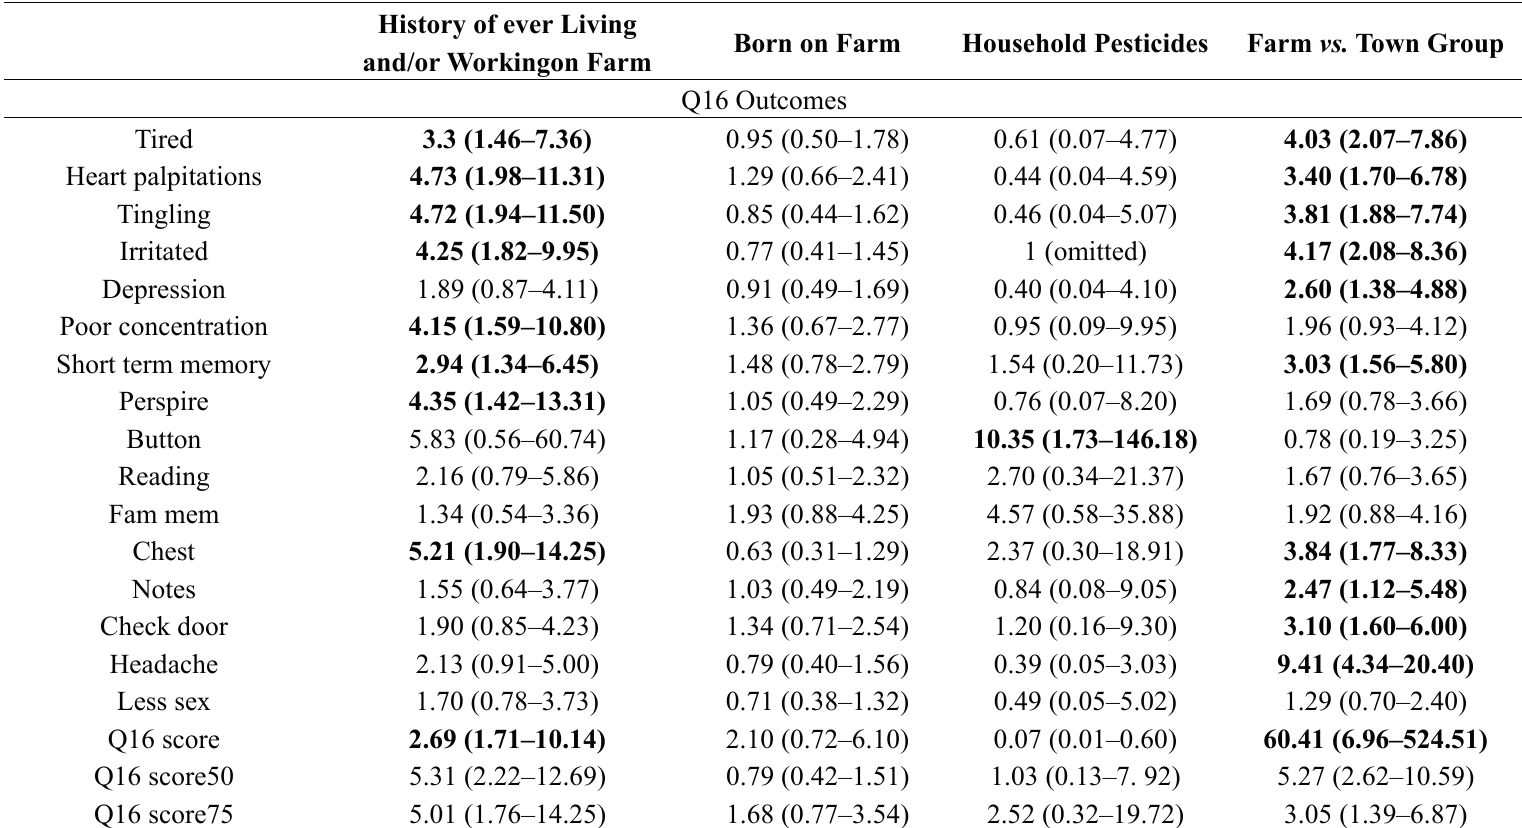
Table 5. Adjusted models for the association between residence/working on a farm, and neurotoxic symptoms among rural women in Western